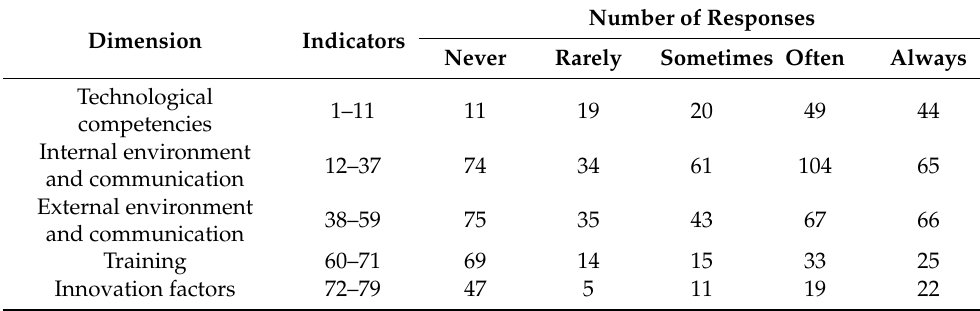
Table 3. Results of quantitative evaluation of the